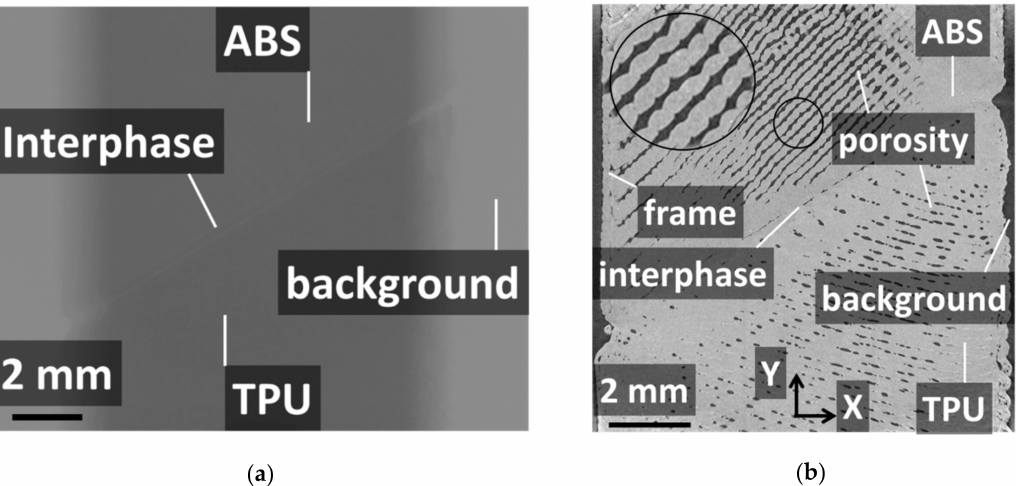
Figure 4. X-ray micro-tomography results: ( a ) Radiographic image of sample AT03 showing the relative contrast between the external air (background), TPU, ABS phases, porosity, and interphase region; ( b ) in-plane cross-section view showing the porous network and the interface layer between ABS and